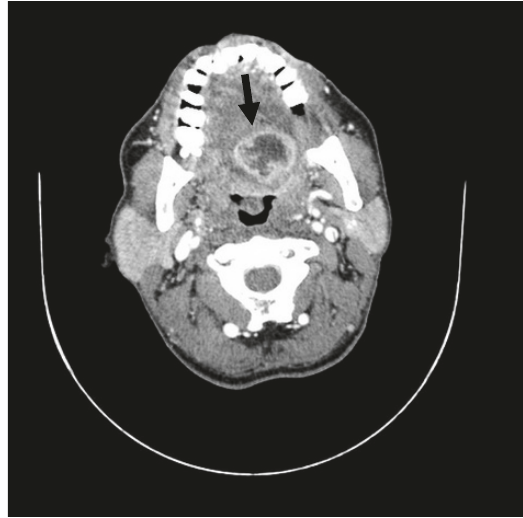
Figure 2: Contrast-enhanced CT scan demonstrated an abscess at left posterior tongue (arrow).